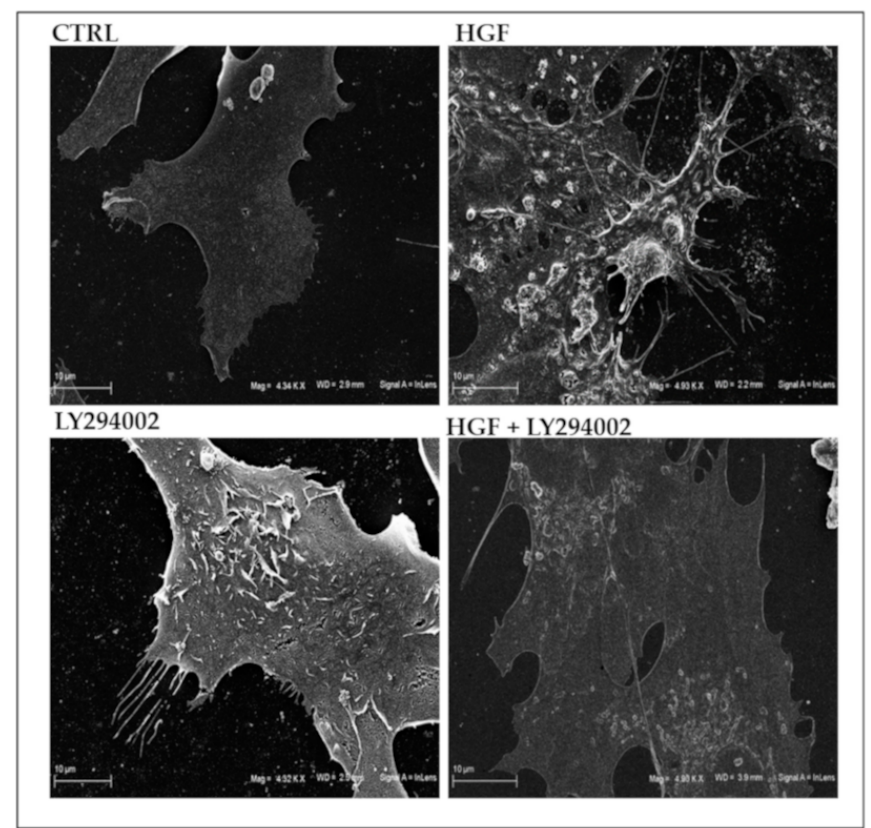
Figure 3. Scanning electron microscopy analysis. Representative images of NT2D1 cells cultured for 24 h in control conditions, or treated with HGF, LY294002, or their combination. Scale bar: 10 µ